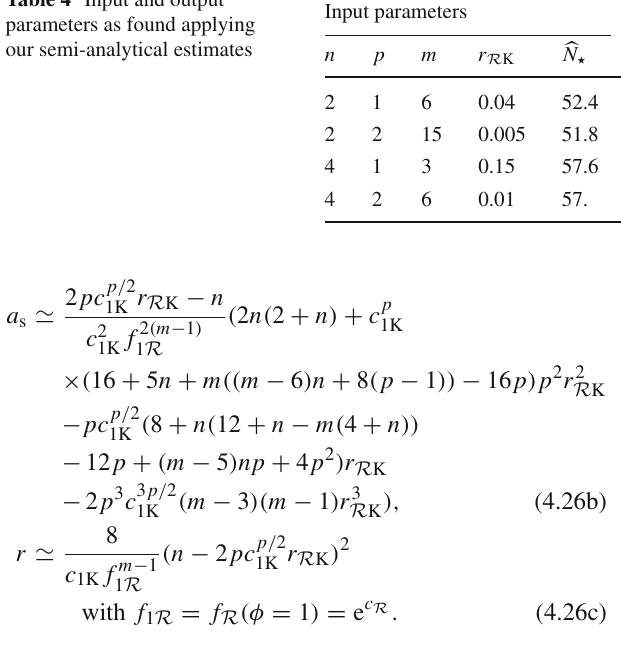
parameters as found applying our semi-analytical